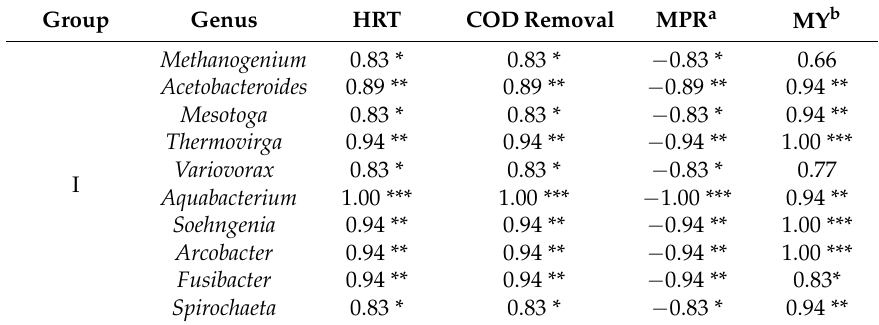
Table 2. Spearman correlation coefficients ρ and the level of the p values ( *** <0.01; ** <0.05; and * <0.1) between selected process parameters and relative abundance at the genus